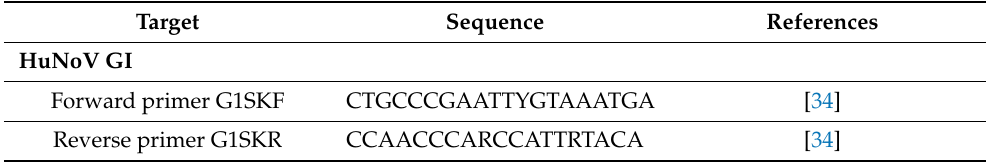
Table 2. Specific primers used for endpoint PCR and Sanger sequencing.